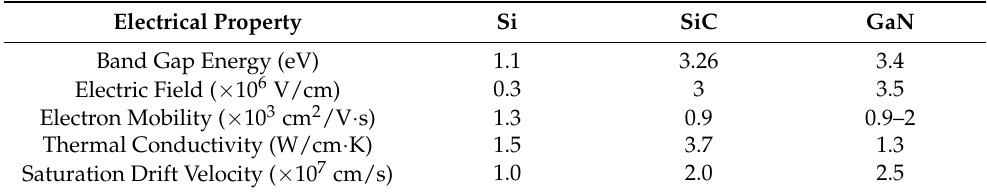
Table 1. Physical Properties of SiC, GaN, and Si materials.